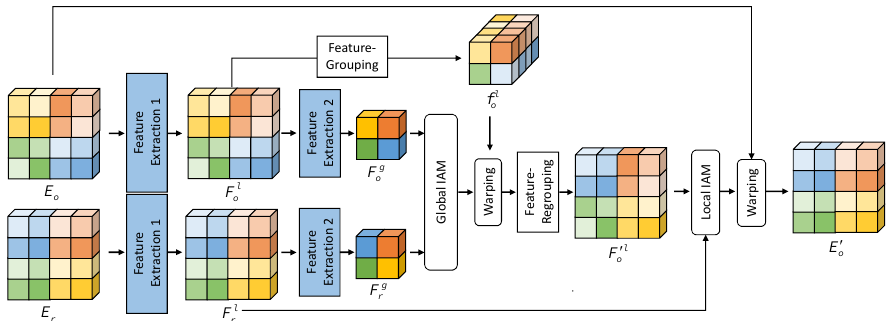
(cid:110) (cid:111) F g r , F g o at a coarse level. After warping